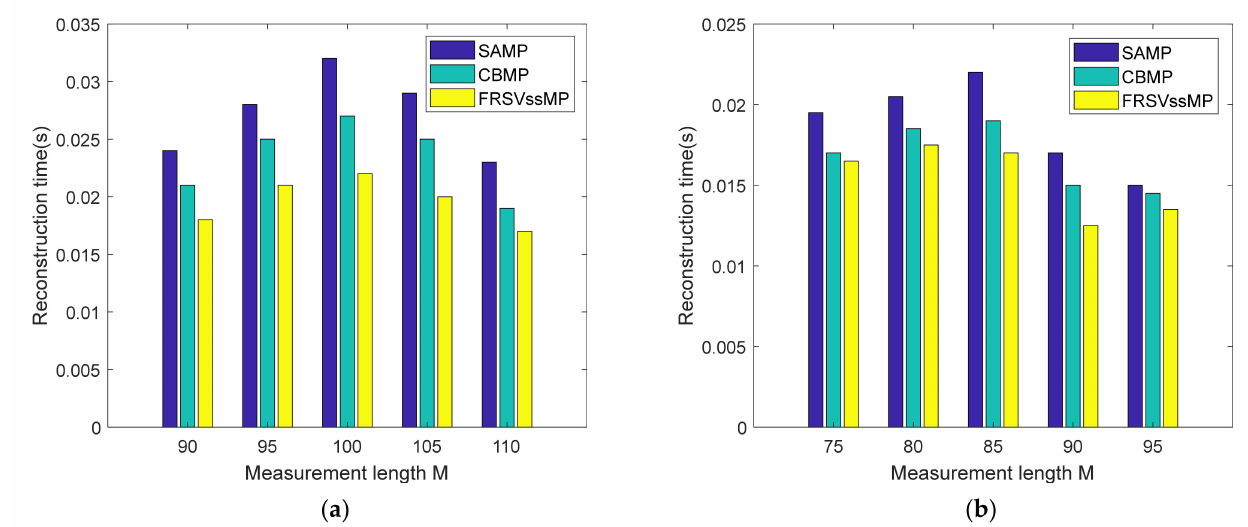
Figure 9. Reconstruction time vs. the measurement length. ( a ) Synthetic signals; ( b ) Real signals.